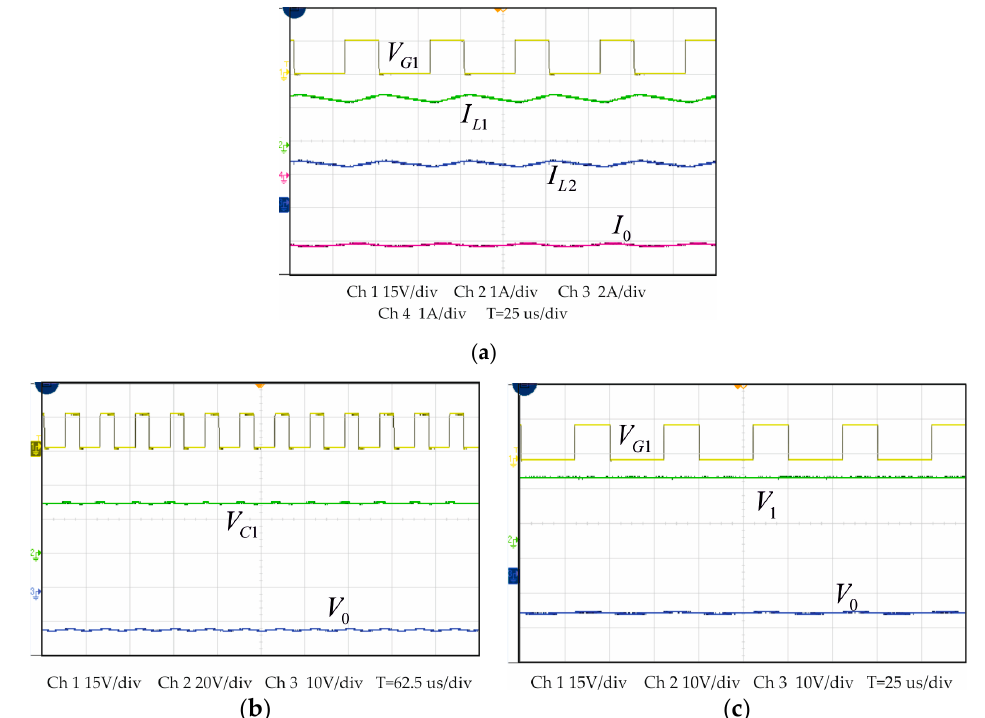
Figure 15. Various voltage and current measurements from experiments during Mode 1 with source 1 (Buck mode): ( a ) Gate signal, inductor currents through L 1 , L 2 and load current (CH 1–4); ( b ) Gate signal and capacitor voltages across C 1 and C 2 (CH 1–3); ( c ) Gate signal, source voltages and output voltage (CH 1–3).